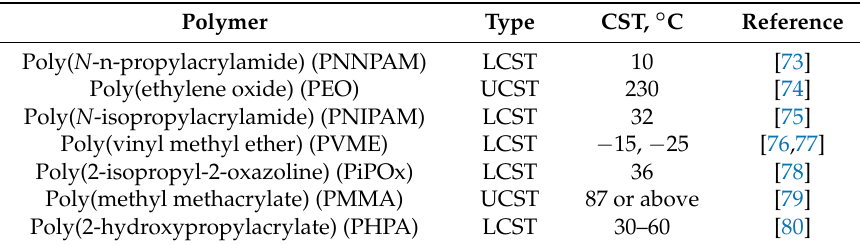
Table 3. Examples of thermo-responsive polymers.